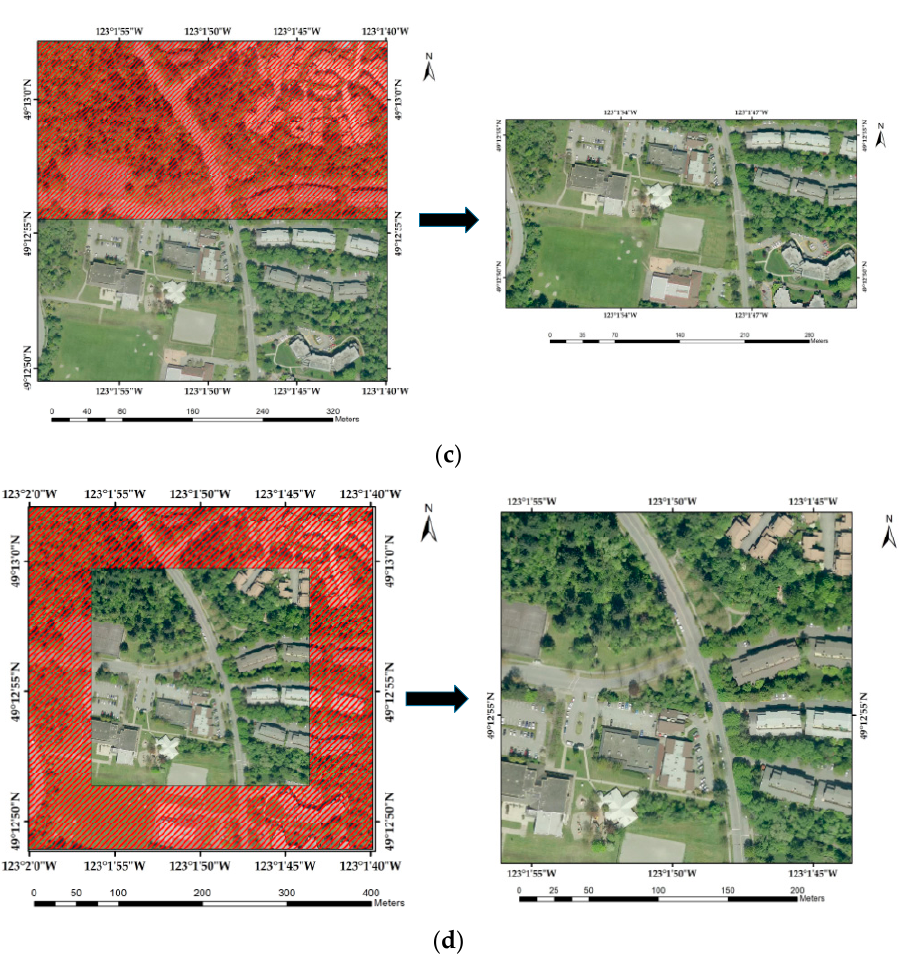
Figure 5. Examples of image cropping attack with different attack strengths: ( a ) Attack strength of 0.25; ( b ) Attack strength of 0.4; ( c ) Attack strength of 0.5; ( d ) Attack strength of 0.6.